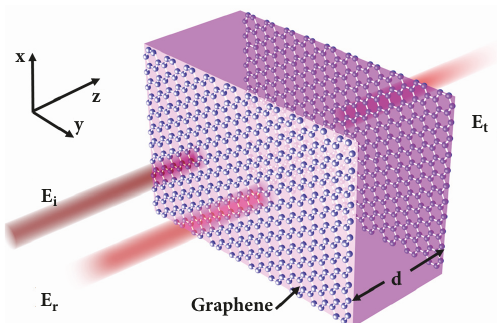
Figure 1: Schematic diagram of a pair of parallel graphene layers with the insertion of dielectric slab. A plane wave of amplitude 𝐸 𝑖 is incident on the structure,giving rise to a reflected and a transmitted wave with amplitudes 𝐸 𝑟 and 𝐸 𝑡 ,